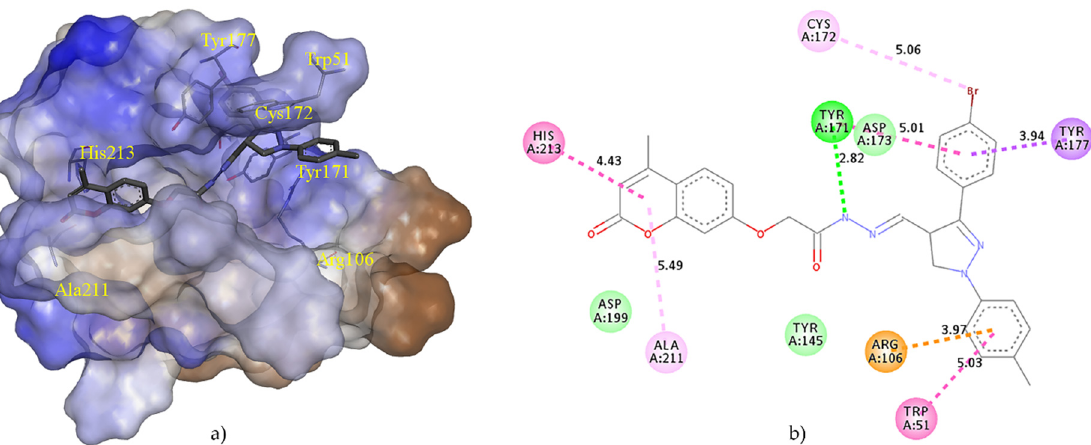
Figure 2. The main interactions of compound 3 with residues in the binding site of endoglucanase I (pdb ID: 2OVW): ( a ) Hydrophobic surface representation of endoglucanase I active site with docked compound 3 . Hydrophobicity in range: 3 (brown) to − 3 (blue); ( b ) Two-dimensional diagram of main interactions with interatomic distances (Å). (green = conventional hydrogen bond; light green = van der Waals; brown = π -cation; dark purple = π – σ interactions; light purple = π - π interactions; pink = alkyl and π -alkyl interactions).